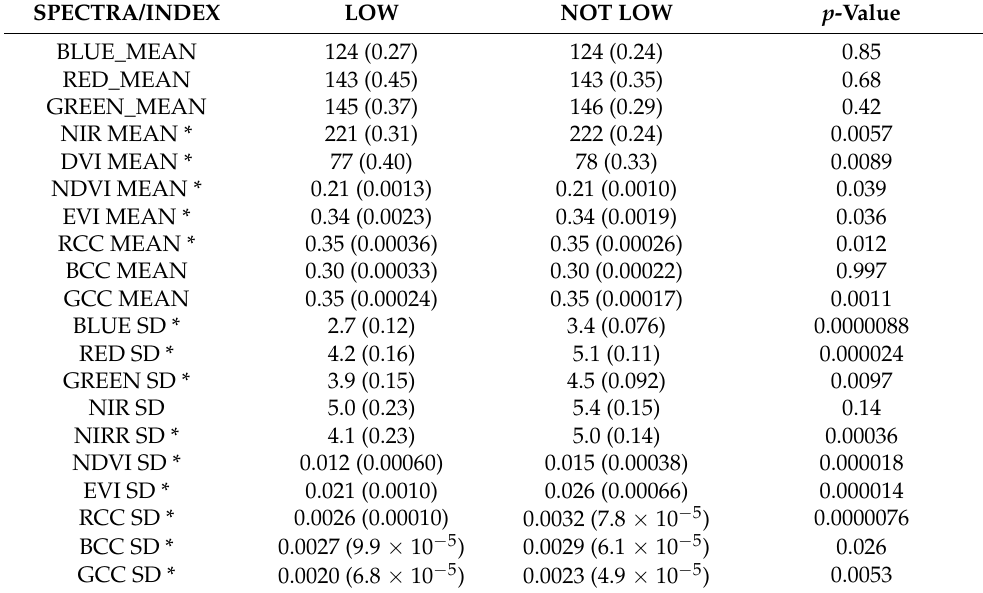
Table 4. Individual tree crown (ITC) spectra/index attribute values (MEAN and SE) for trees in the two vigor classes. Marked (*) attributes are significantly different ( p < 0.05) between the LOW and NOT LOW vigor classes using the Mann–Whitney test for differences in means. Indices defined: DVI = difference vegetation index; NDVI = normalized differential vegetation index; EVI=enhanced vegetation index; RCC = red chromatic coordinate; BCC = blue chromatic coordinate; GCC = green chromatic coordinate. SD indicates the standard deviation of the pixels within an ITC. For example, GREEN SD is the standard deviation of the green value of all the pixels within an ITC.